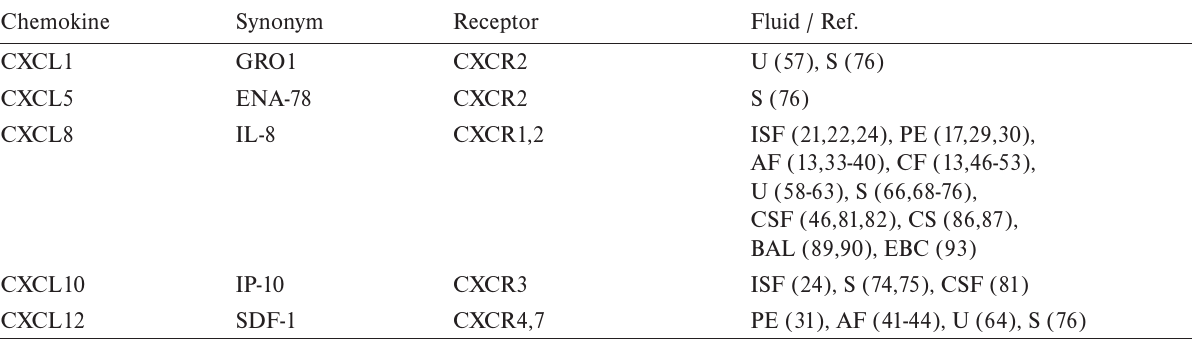
Table 2. CXC Chemokines in tumor proximal fluids.